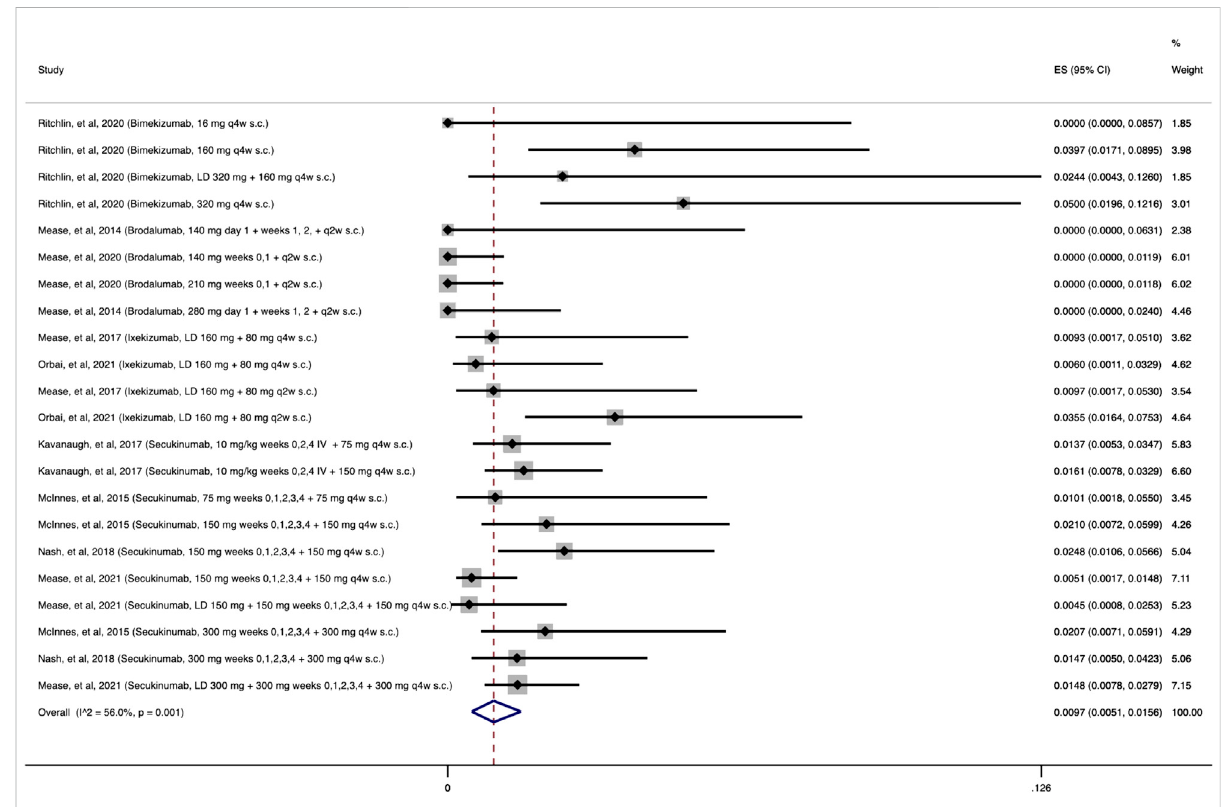
FIGURE 6 Opportunistic Candida spp. infections cumulative incidence for anti-IL-17 during RCTs and their extension periods. Individual and combined estimatesofthecumulativeincidence ofopportunistic Candida spp.infections forpatientstreatedwith anti-IL-17 with95%con fi denceintervals.ES: Effect Size (Cumulative incidence).